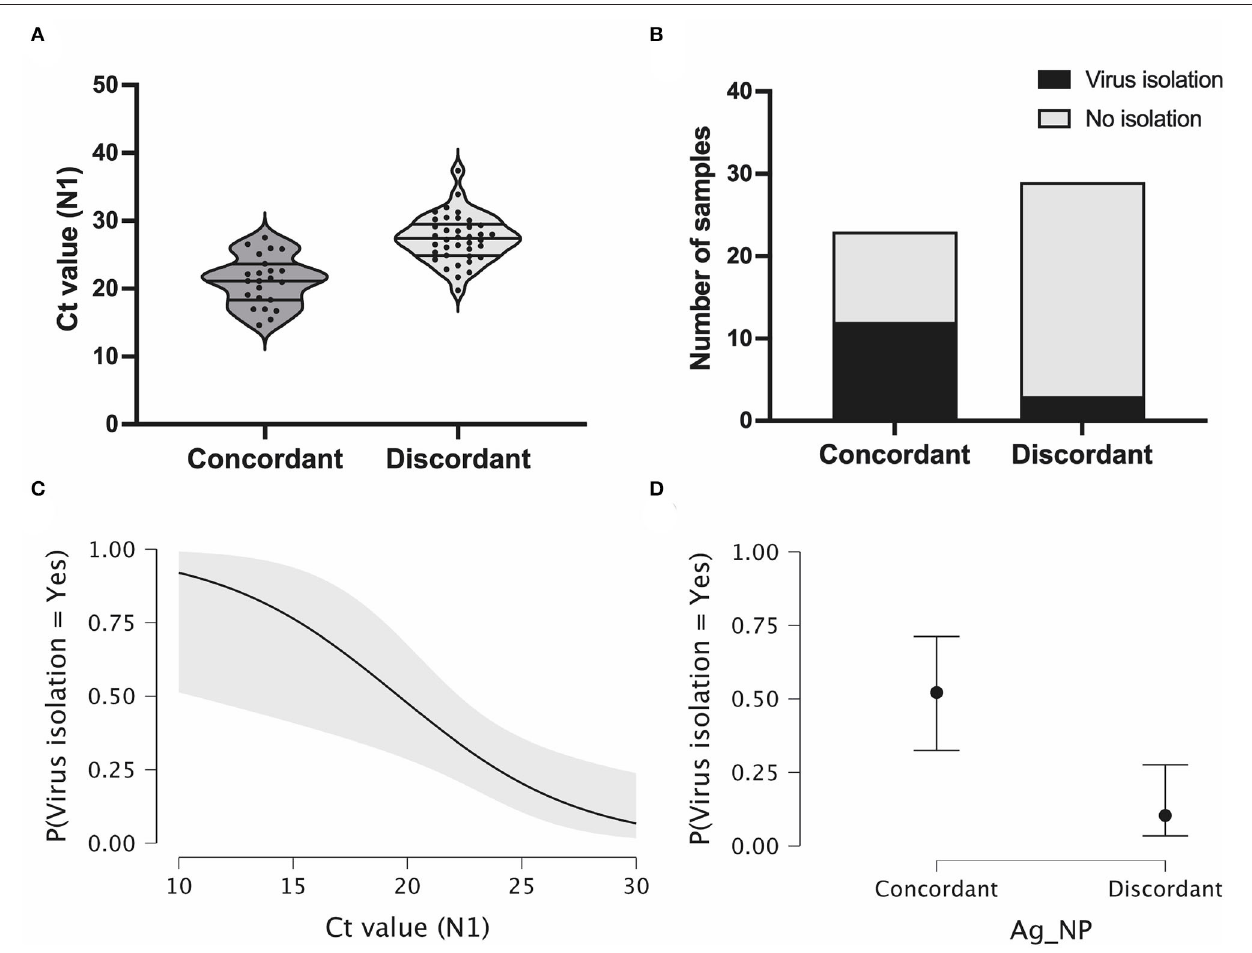
FIGURE 4 | Antigen discordant samples have higher C t and lower viral isolation rates compared with discordant samples. (A) Violin plot showing RT-PCR C t values (N1 target gene) in antigen concordant (RT-PCR + /Ag-RDT + , n = 23) and discordant (RT-PCR + /Ag-RDT-, n = 29) samples used for virus isolation experiments, and lines represent the median and 25–75% quartiles. (B) Virus isolation success in total number of antigen concordant ( n = 23) and discordant ( n = 29) samples. (C,D) Viral isolation probability considering RT-PCR C t values (N1 target gene) and nasopharyngeal antigen rapid test (Ag-NP) result as isolated covariates,